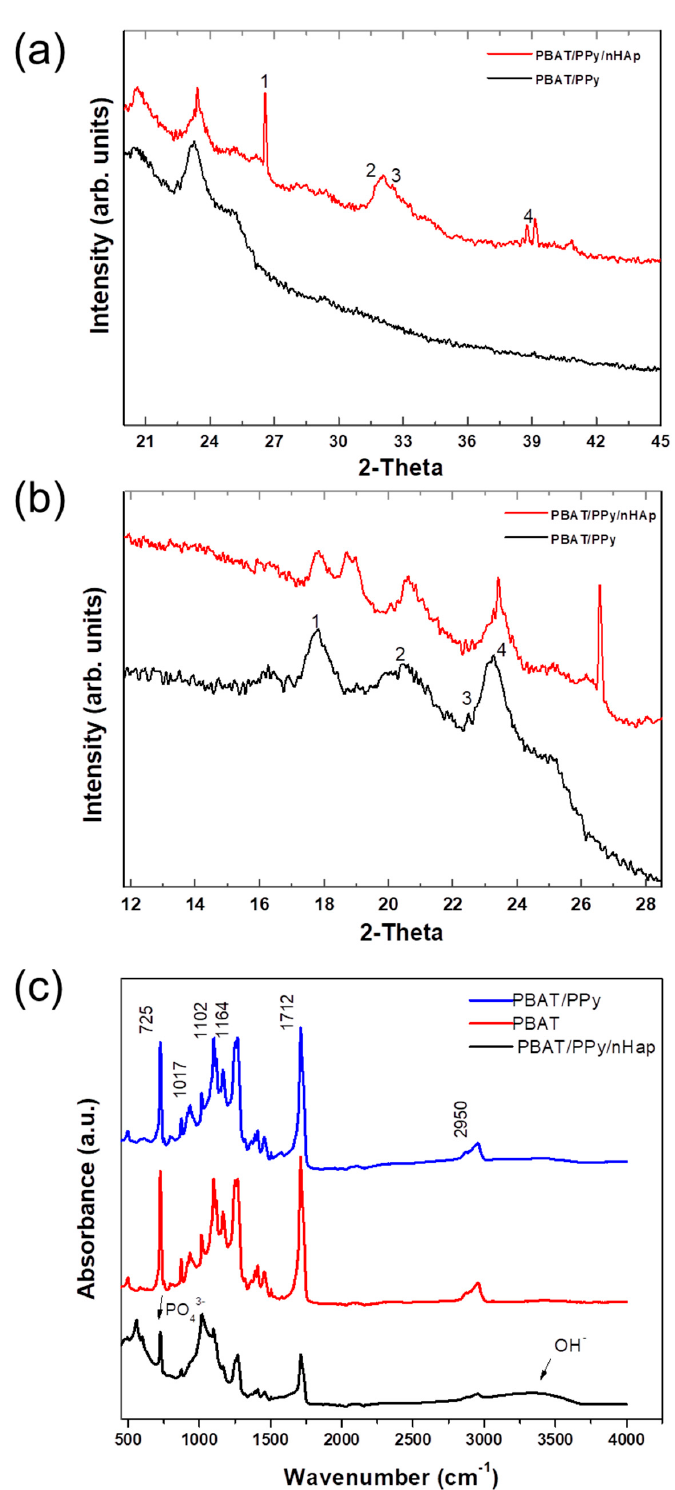
Figure 2. ( a ) X-ray diffraction spectrum of the PBAT/PPy and PBAT/PPy/nHAp scaffolds, with ( b ) a zoom in the 12–30 cm − 1 region, showing the PBAT polyester. ( c ) ATR-FTIR spectra of the PBAT, PBAT/PPy, and PBAT/PPy/nHAp scaffolds. In Figure ( a ) 2 θ angles (1) = 26.5°, (2) = 31.9°, (3) = 32.4°, and (4) = 38.7°. In Figure ( b ) 2 θ angles = (1) = 17.7°, (2) = 20°, (3) = 22.5°, and (4) = 23.3°.